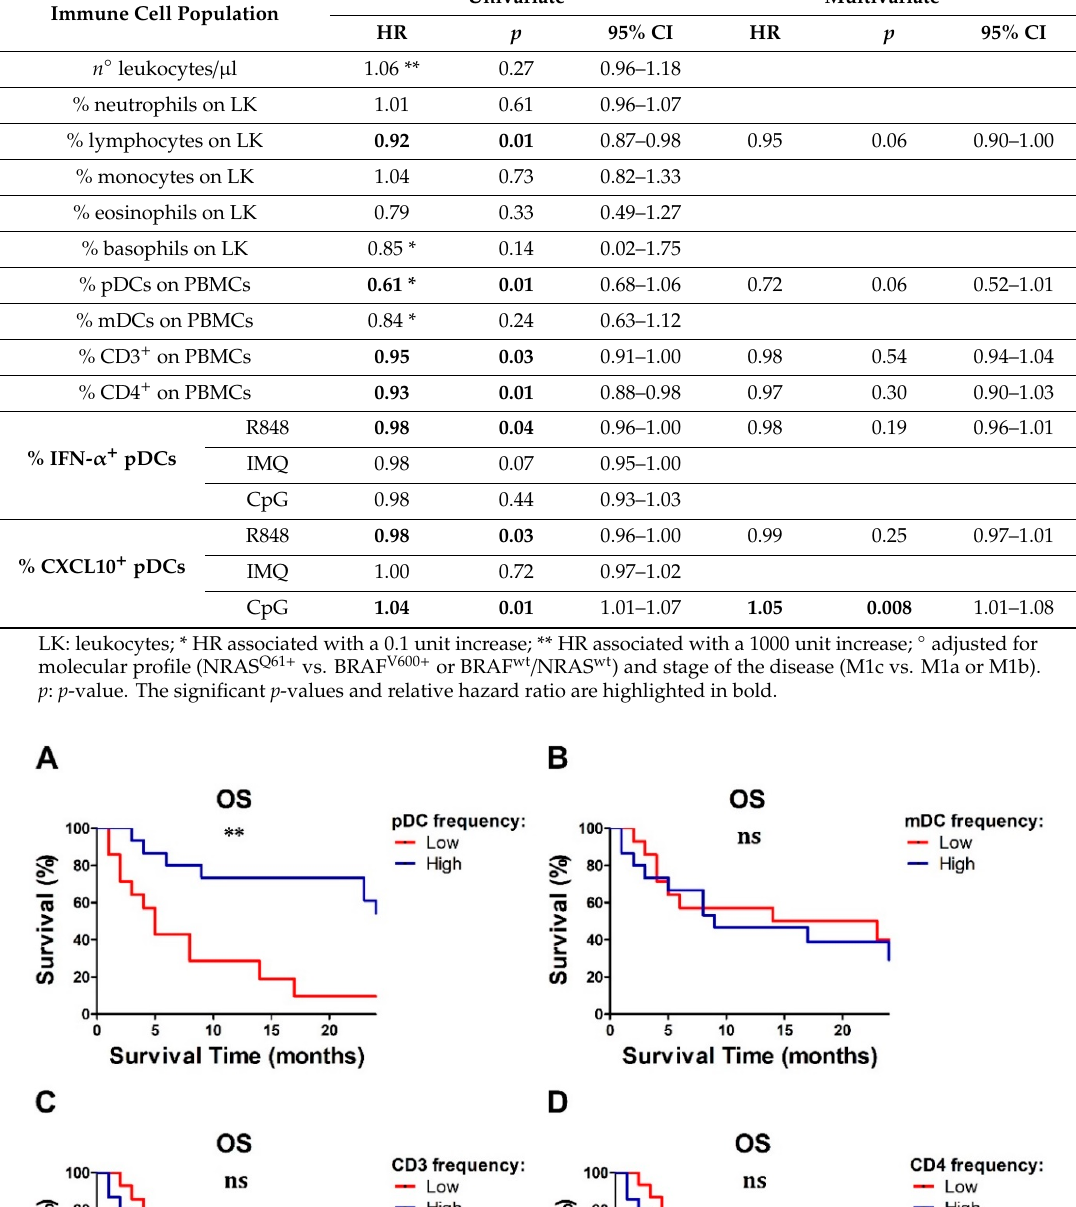
Table 5. Univariate and multivariate Cox regression models for OS in MM patients at baseline (T0; N = 29). Immune Cell Population